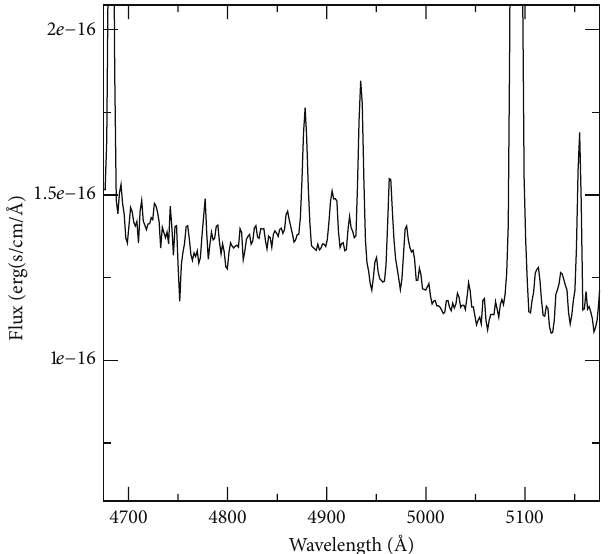
Figure 5: Optical spectrum obtained by coadding the two spaxels in WR038 where the Wolf-Rayet blue bump is